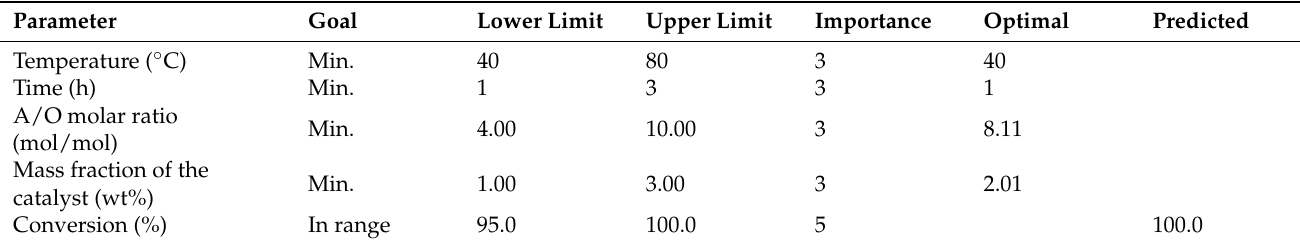
Table 4. The optimization goals and obtained optimal